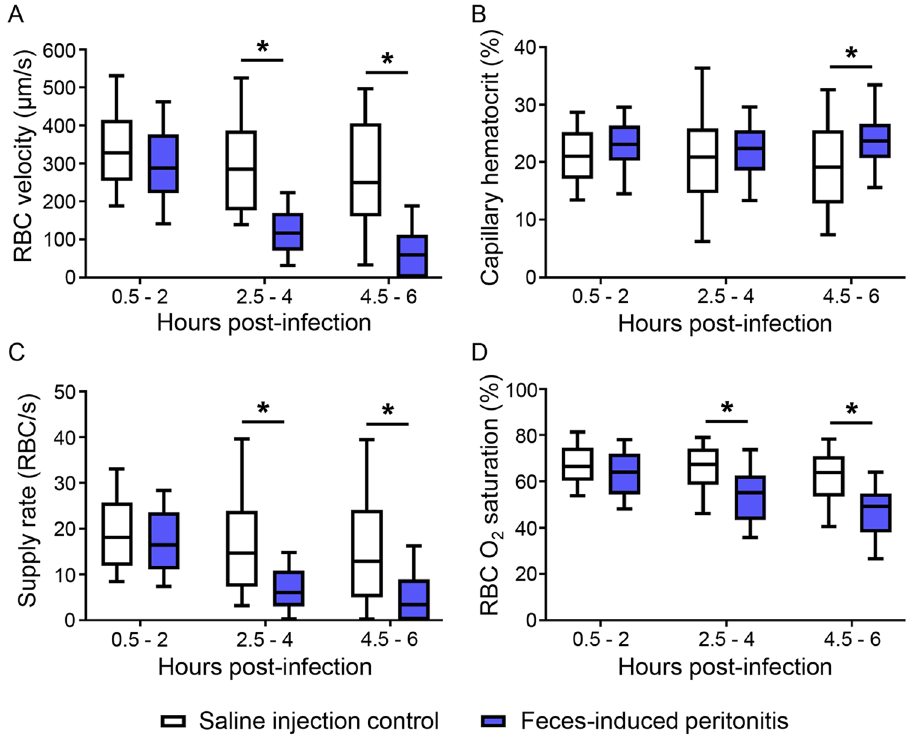
Figure 4. Capillary red blood cell (RBC) dynamics and O 2 saturation in skeletal muscle deteriorate early in feces-induced peritonitis model of sepsis. RBC velocity ( A ), hematocrit ( B ), supply rate ( C ) and O 2 saturation ( D ) were derived from intravital video microscopy of the extensor digitorum longus recorded 0.5–2 h, 2.5–4 h and 4.5–6 h after induction of peritonitis. Data were pooled from approximately 8 fields of view from each rat in the saline control and feces-induced peritonitis groups, and presented as box and whiskers (median, 10th to 90th percentile), n = 10 rats, two-way ANOVA with Bonferroni correction, * P < 0.05 compared with